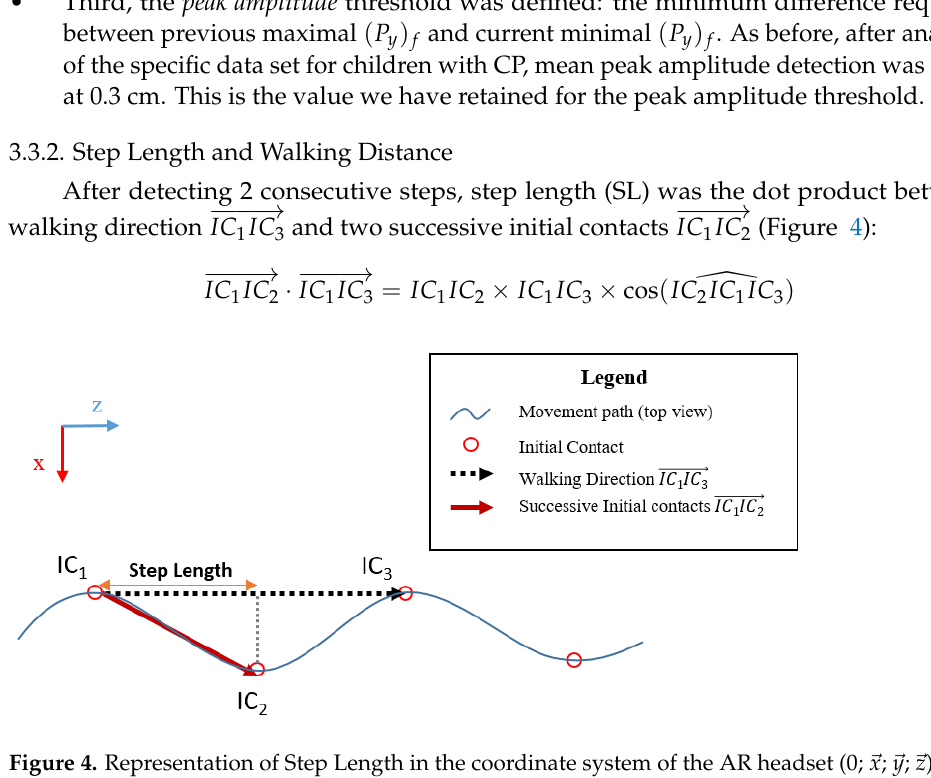
Figure 4. Representation of Step Length in the coordinate system of the AR headset (0; (cid:126) x ; (cid:126) y ; (cid:126) z ). Finally, the total walking distance was the sum of the successive step